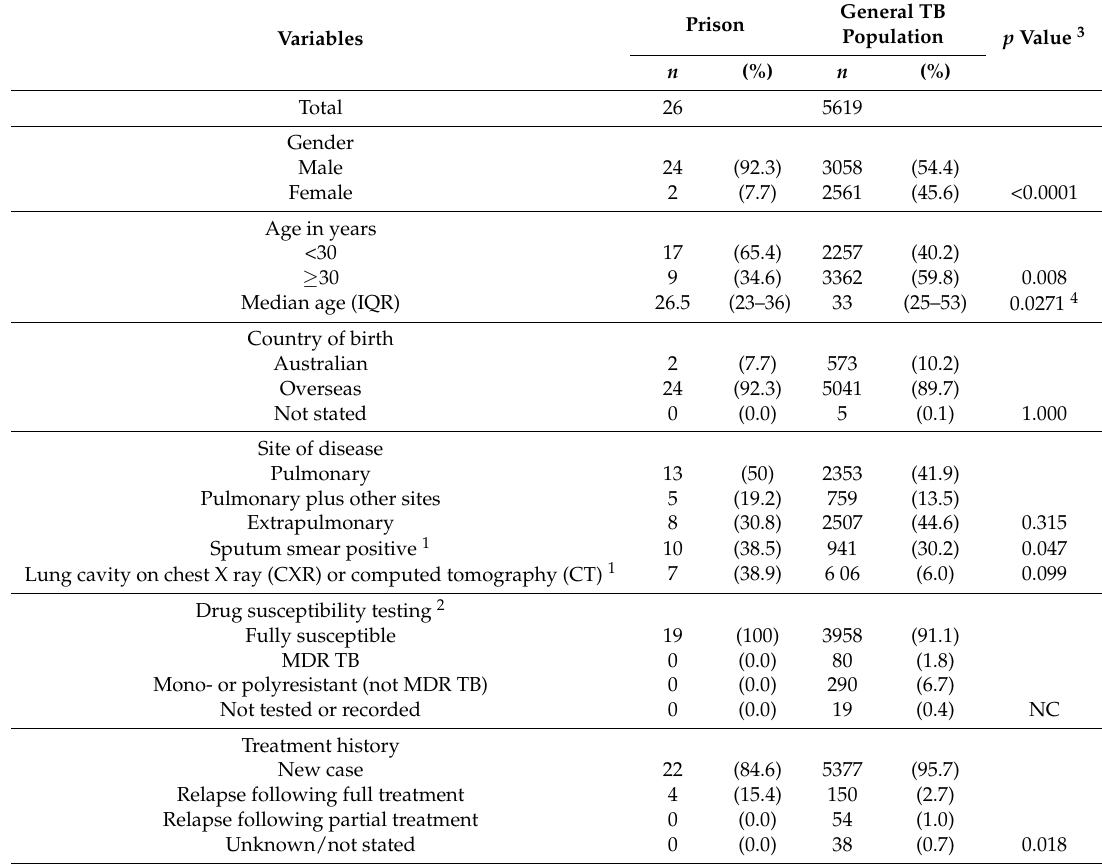
Table 1. Characteristics of